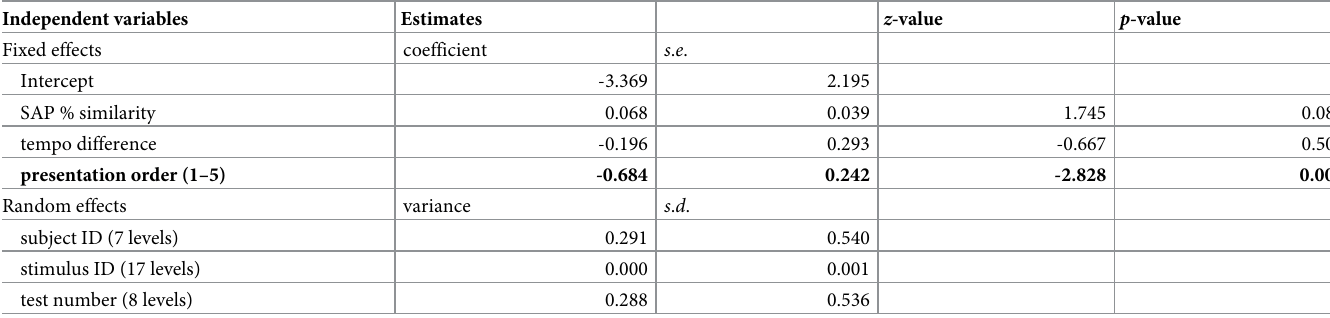
Table 2. Effect of song similarity on females’ response to unfamiliar